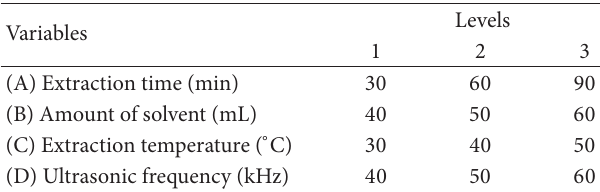
Table 1: Orthogonal experimental design factors and levels for ultrasonic-assisted extraction